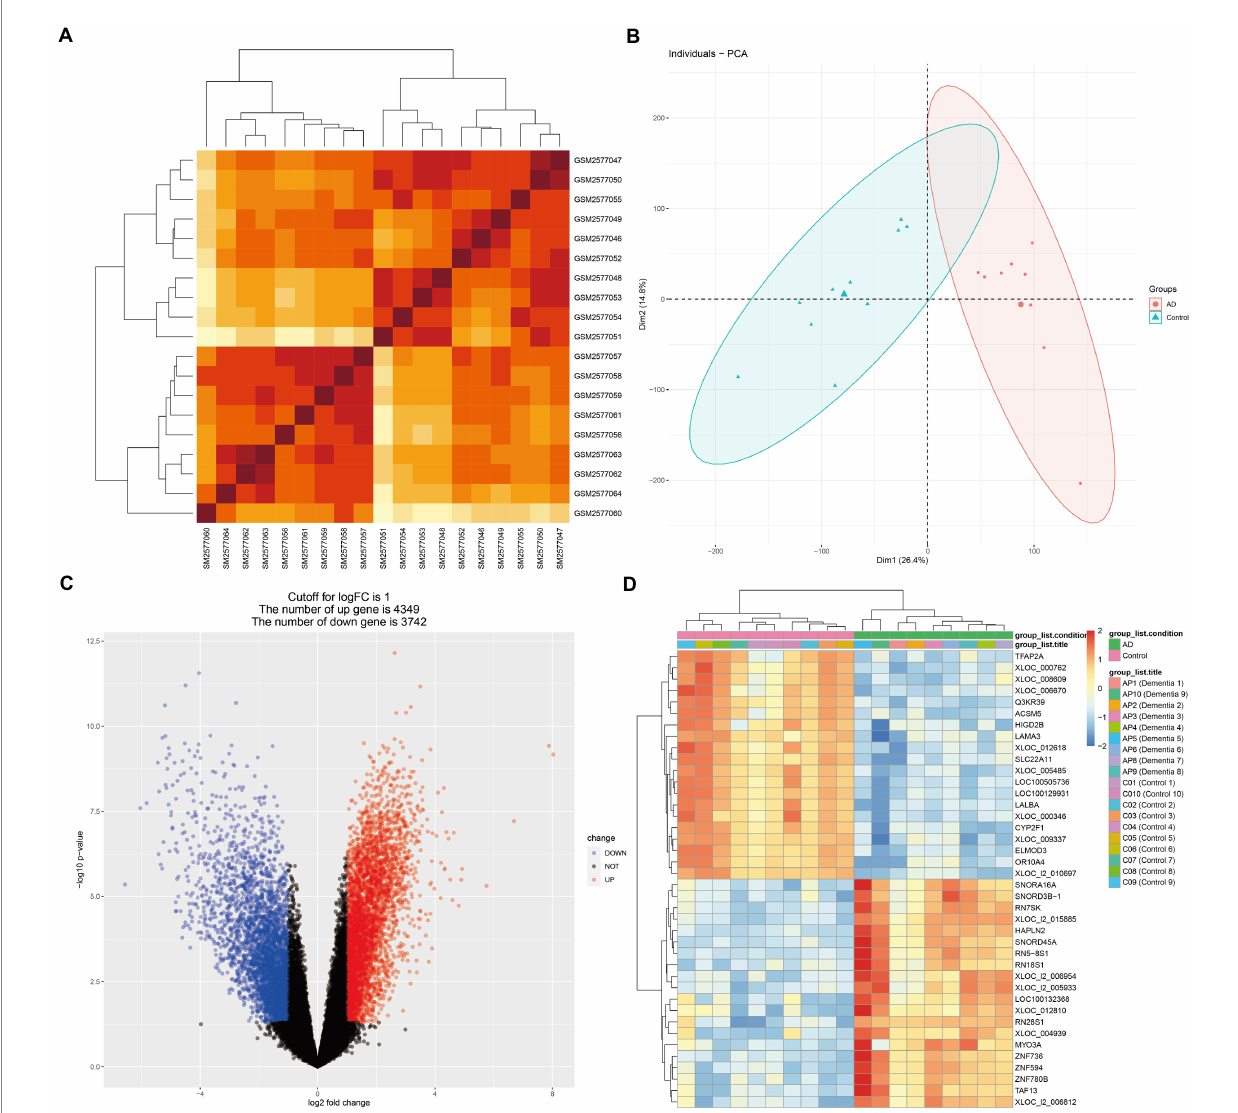
FIGURE 2 Microarray normalization and differential gene analysis in the AD group. (A) The heatmap of AD, (B) The PCA map of AD, (C) The volcano map of AD, and (D) Differential heatmap of partial gene expression between AD and normal